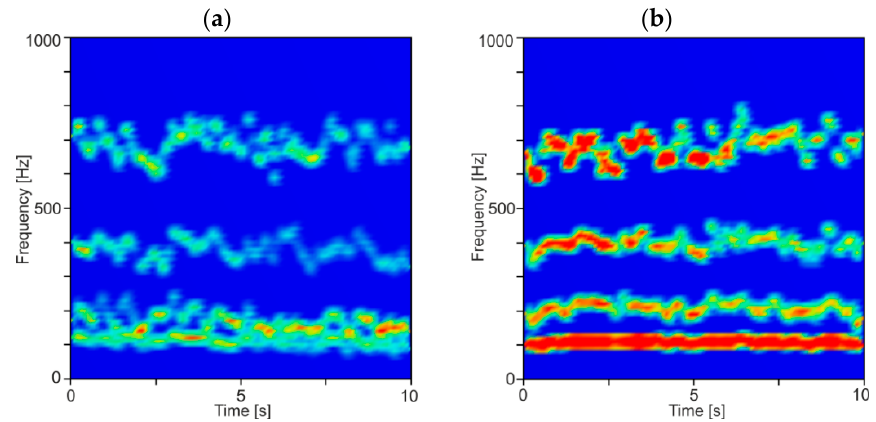
Figure 9. Time–frequency spectrogram for: ( a ) stable ( a p = 0.5 mm, n = 8000 rpm) and ( b ) unstable cutting ( a p = 0.5 mm, n = 7000 rpm).